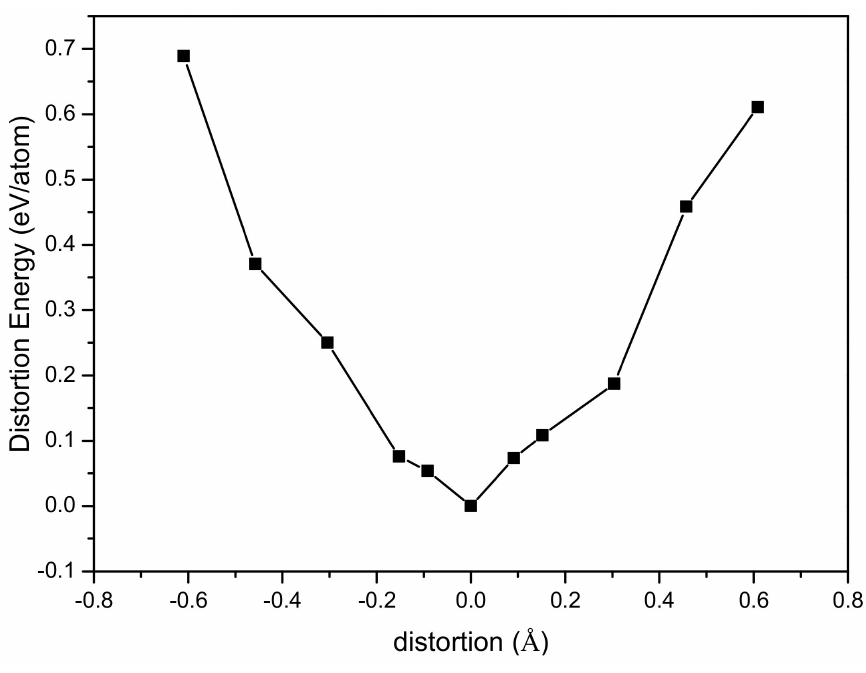
Figure 8. The distortion energies of Sb 2 Te 3 vary with the distortion distances along the <001>